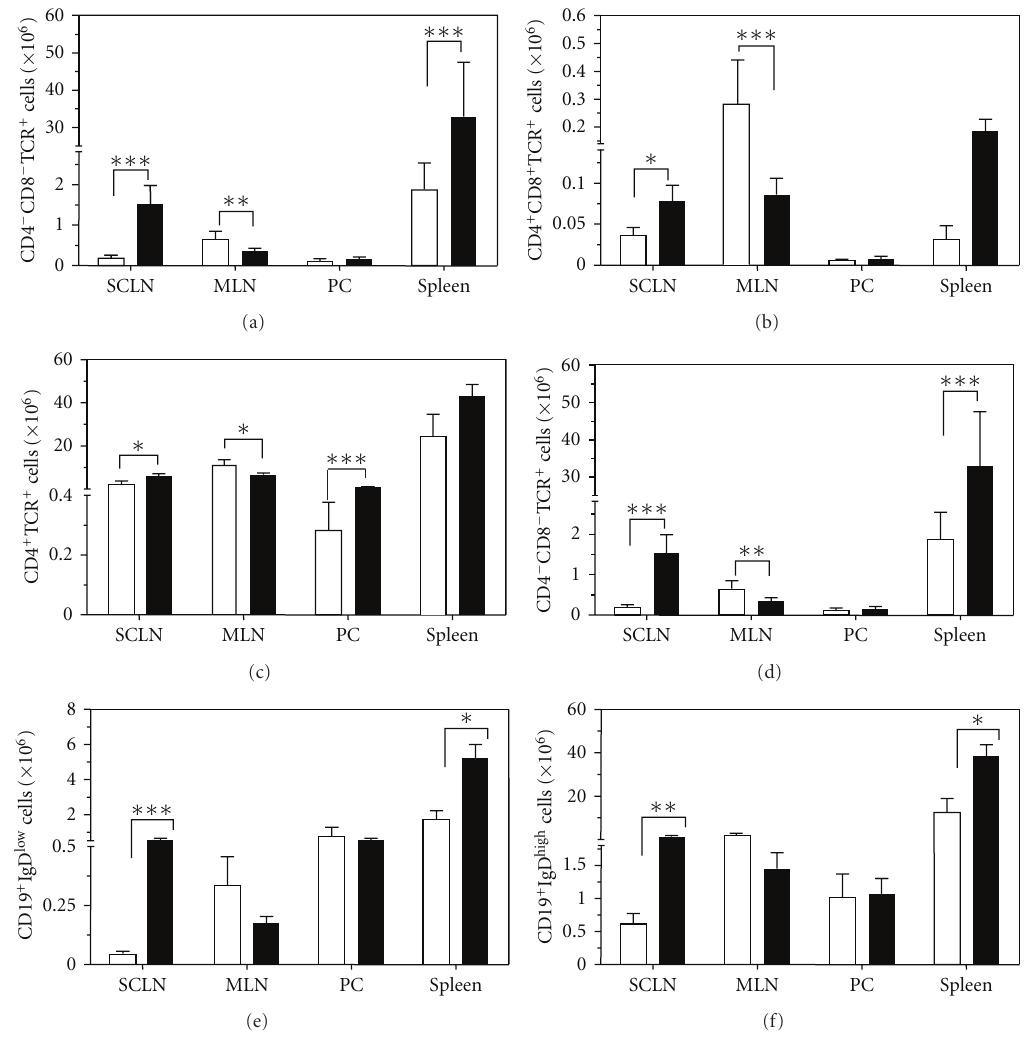
Figure 1: Lymphocyte subsets in central and peripheral lymphoid organs from T. cruzi acutely infected mice . Male BALB/c mice were infected intraperitoneally with 10 2 culture-derived trypomastigotes of T. cruzi (Tulahu´en strain), and 14 days after infection the subcutaneous lymph nodes (SCLN), mesenteric lymph nodes (MLN), peritoneal cavity cells (PC), and spleen were harvested to perform flow cytometry. Erythrocytes were previously depleted in the spleen cell suspensions by treatment with Tris-bu ff ered ammonium chloride. The total number of (a) double-negative CD4 − CD8 − T cells, (b) double-positive CD4 + CD8 + T cells, (c) single-positive CD4 + T cells, and (d) CD8 + T cells, (e) CD19 + IgD low B cells and (f) CD19 + IgD high B cells are indicated for each histogram. Values represent the mean and standard error. The infected group ( n = 5–14) were compared to noninfected controls ( n = 4–9) with t -test, using the program GraphPad Prism 5. Data were considered significant if P values were < 0.05. ∗ P < 0 . 05, ∗∗ P < 0 . 01, ∗∗∗ P < 0 .